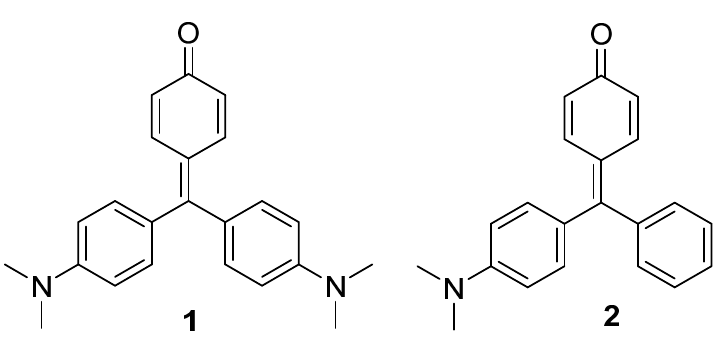
Figure 1. Triaryl methane dyes 1 and 2 with a quinone methide